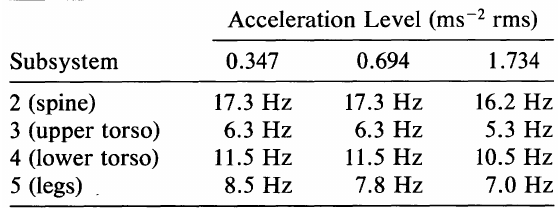
Table 1. Undamped Natural Frequencies Calculated from Modeling